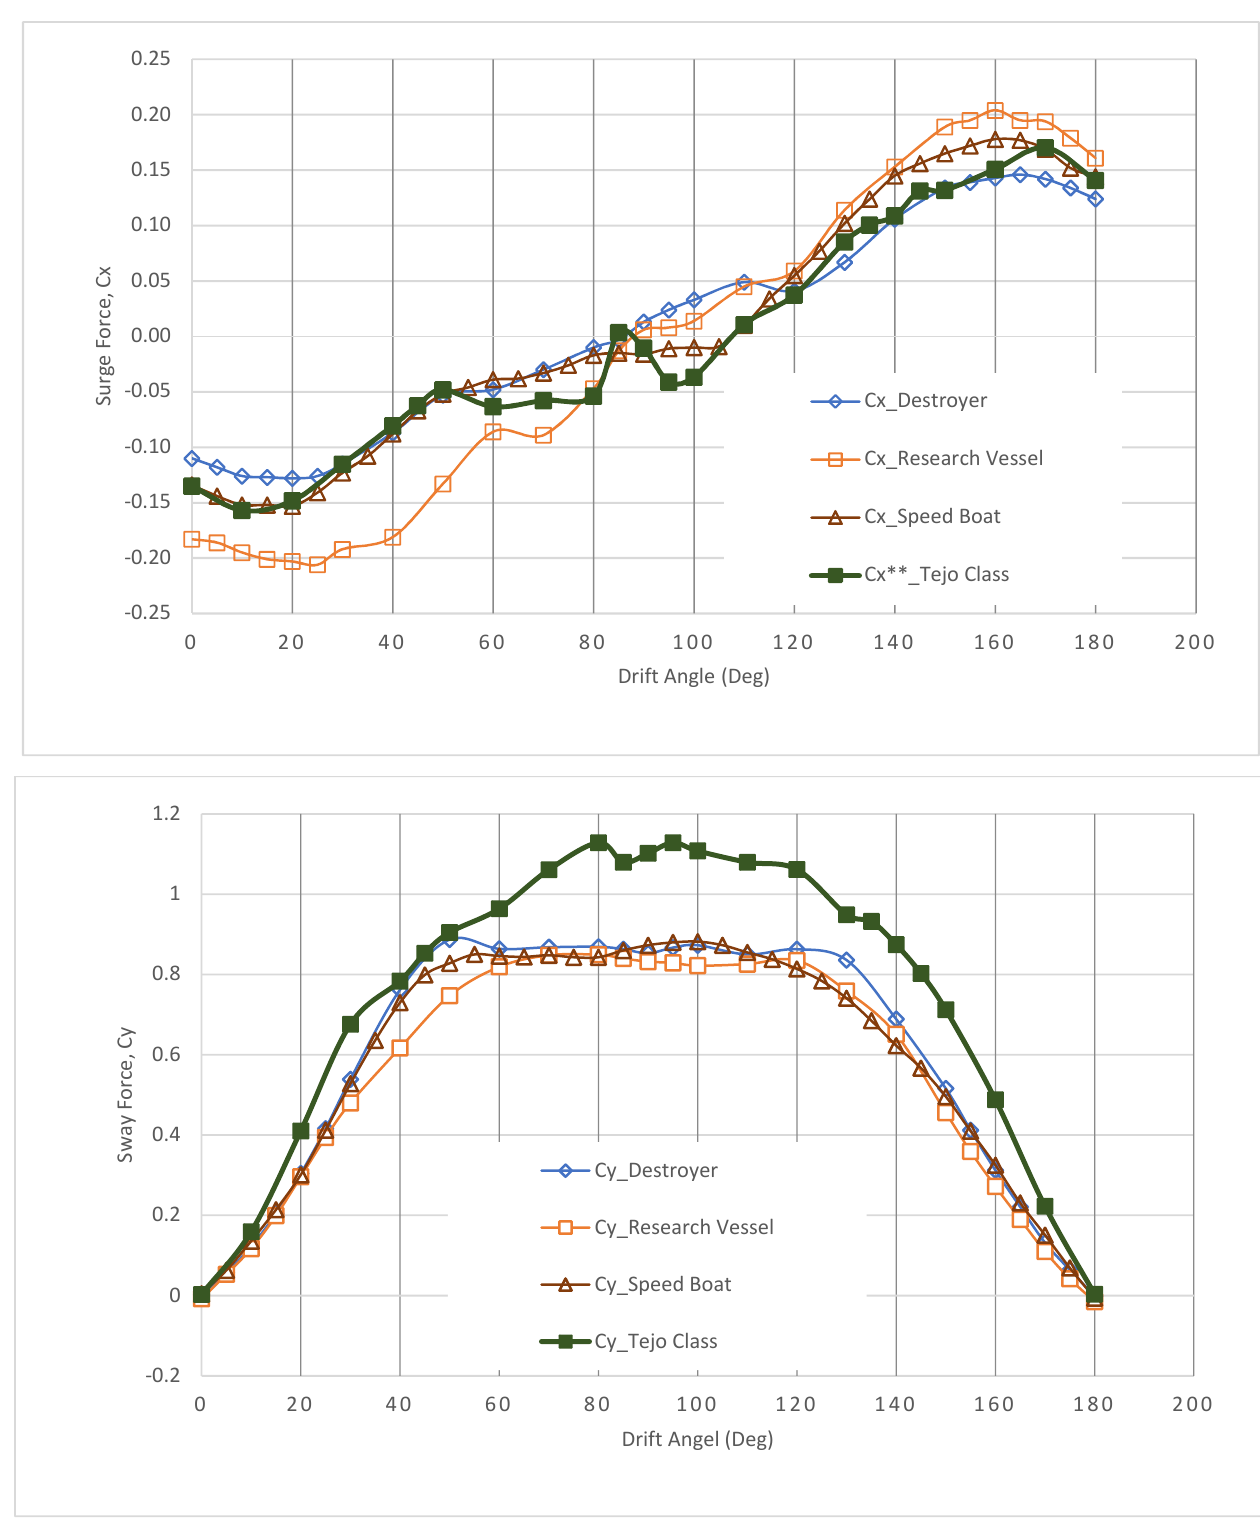
Figure 15. Relative comparison among force results for the Tejo vessel and three other ship models from Blendermann [13]. For the non-dimensionalizaiton of the surge force (Cx), a different formulation has been used here, as used by Blenderman. Thus, it has been marked as Cx**.